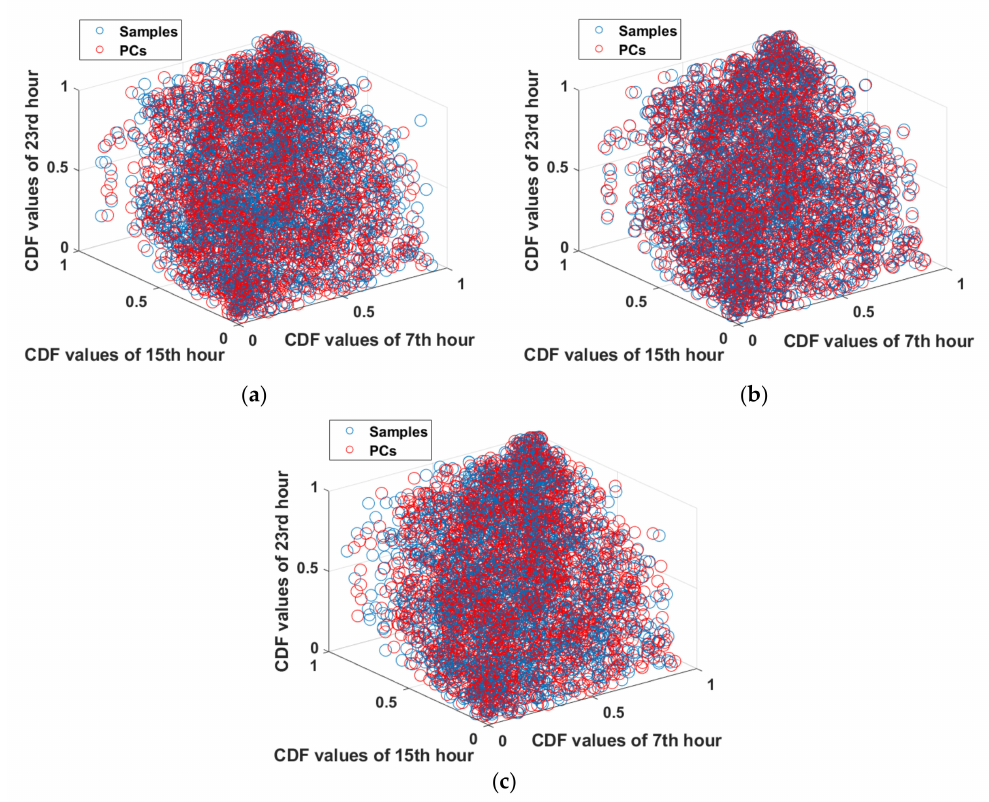
Figure 6. Sample scatter plots with related first PCs ( a ) for WF 1, ( b ) for WF 2, ( c ) for WF